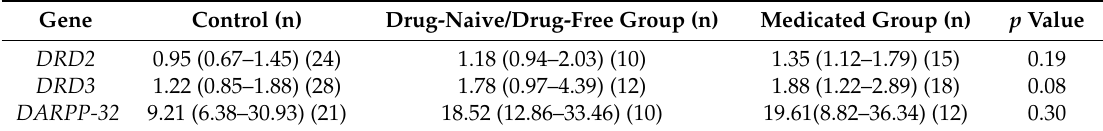
Comparison of DRD2 , DRD3 , and DARPP-32 mRNA levels among controls and drug-naive/drug-free and medicated patients (median (interquartile range)).